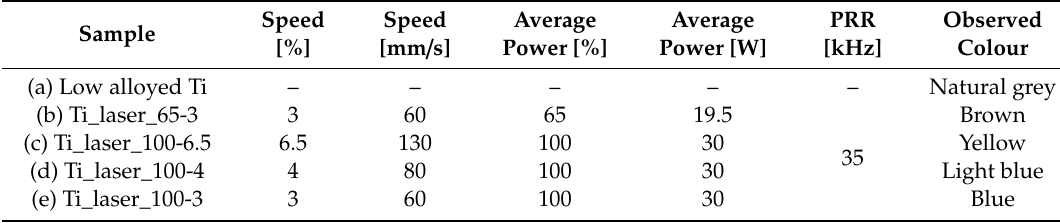
Table 2. Parameters of fibre laser colour